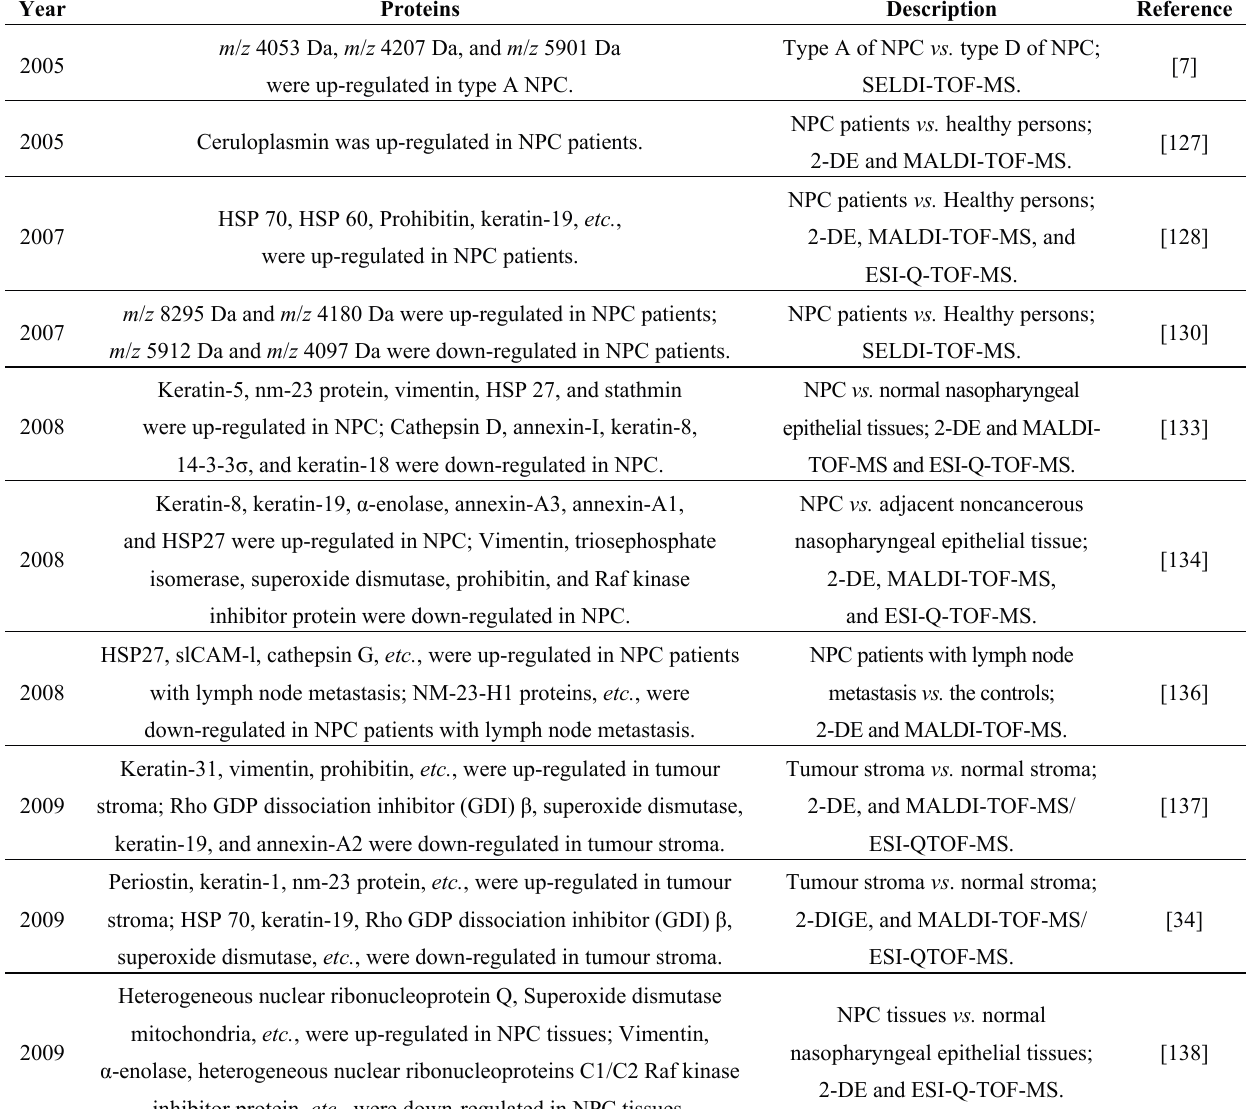
Table 3. The proteomics of human body fluid or tissue related to nasopharyngeal